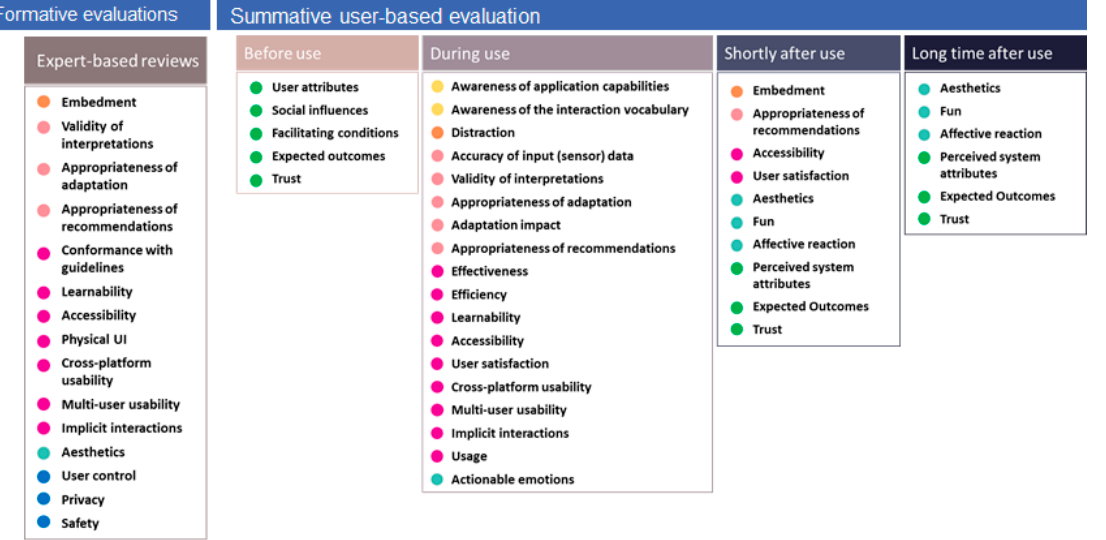
Figure 3. Evaluation approaches employed in the context of the UXIE